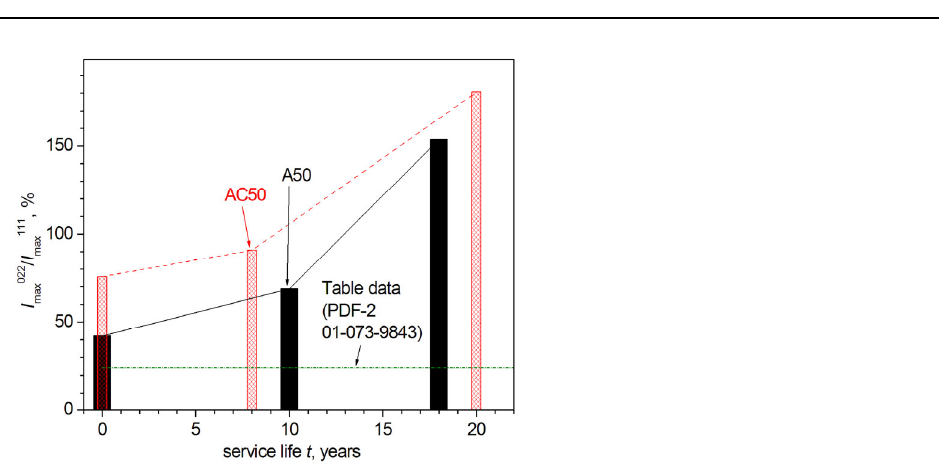
Figure 10. Dependence of the I max 022 / I max 111 ratio on the service life t of the Al wires from the AC50 and A50 cables. Lines connecting the experimental points are guides to the eye only.